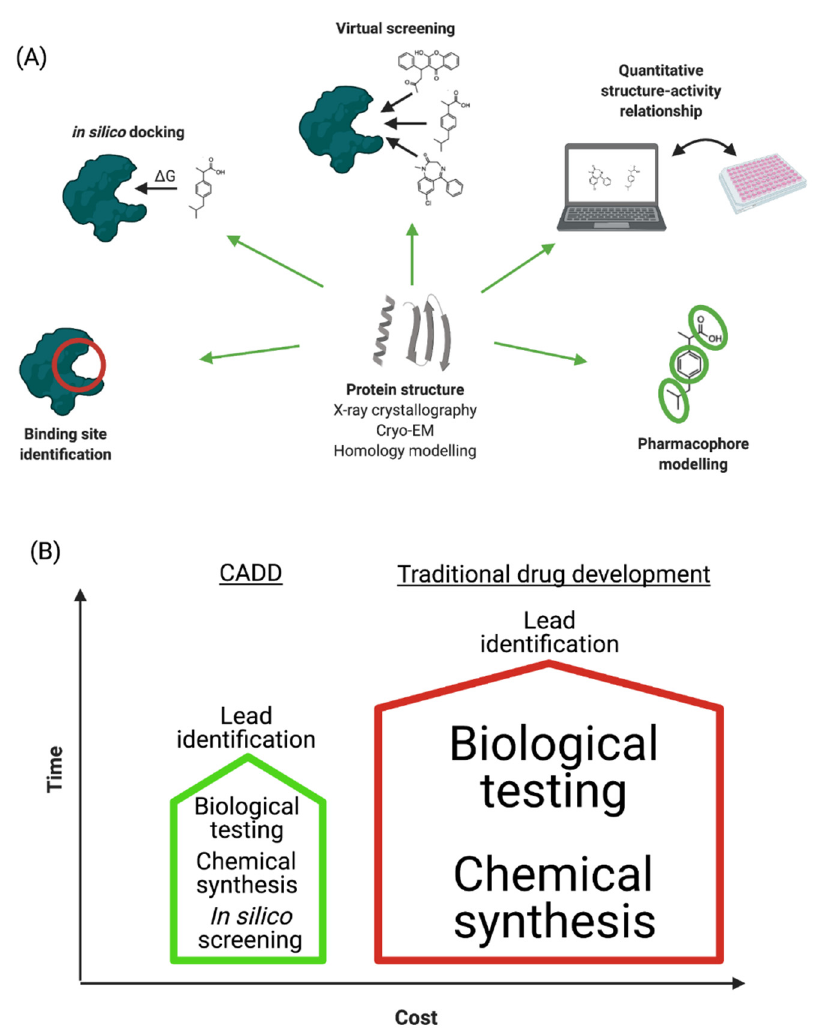
Figure 1. ( A ) Schematic representation of CADD process. ( B ) Comparison of traditional and computer-aided drug development in terms of time and cost investments.